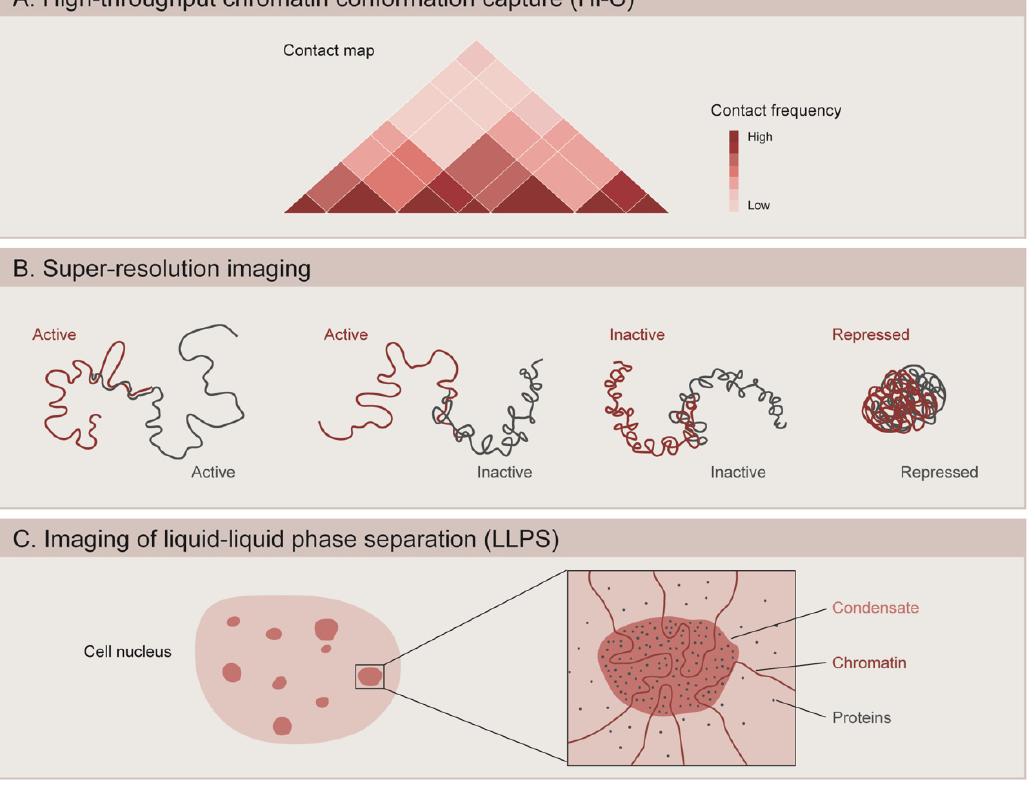
Figure 2. Methods to study the 3D organization of the genome. ( A ) High-throughput chromatin conformation capture (Hi-C) generates contact maps that represent the interaction frequency between genomic loci. Studies using Hi-C have revealed that chromatin is organized into topologically associating domains (TADs). ( B ) Super-resolution microscopy is used to image the spatial organization of different chromatin domains: transcriptionally active (Active), inactive (Inactive), and Polycomb-repressed (Repressed). While active and inactive regions can partially intermix with one another, repressed domains show a more compact configuration and do not overlap with other neighboring domains. ( C ) Microscopy-based methods are used to assess the ability of chromatin components to form condensates through liquid–liquid phase separation (LLPS). Condensate formation is mediated by the biochemical properties of the macromolecules and their interactions.